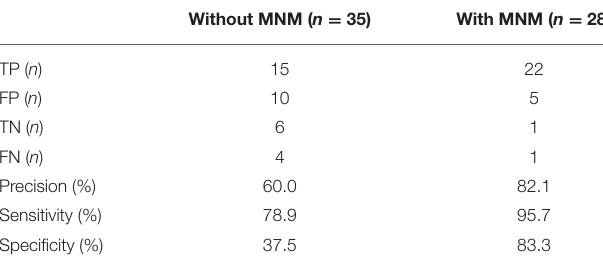
TABLE 3 | Evaluation indicators of MNM-guided